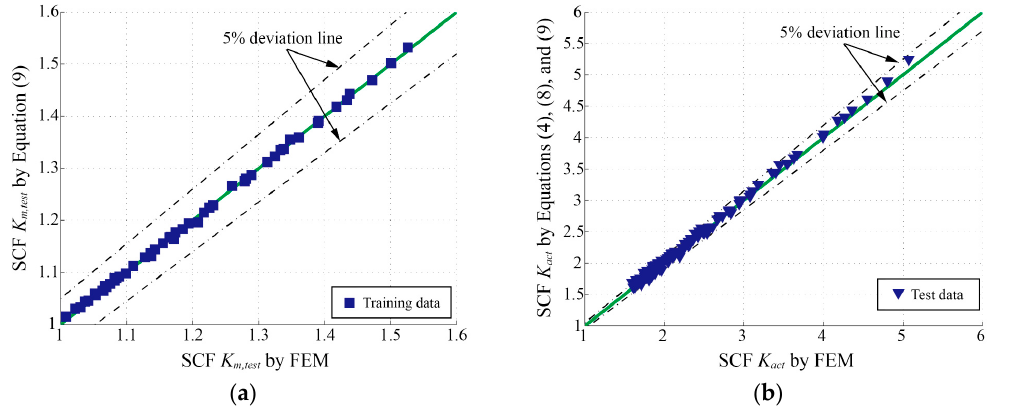
Figure 13. Comparison of the SCF determined by FEM and parametric formulae: ( a ) comparison of K m,test in training data system; ( b ) comparison of K act in test data system.